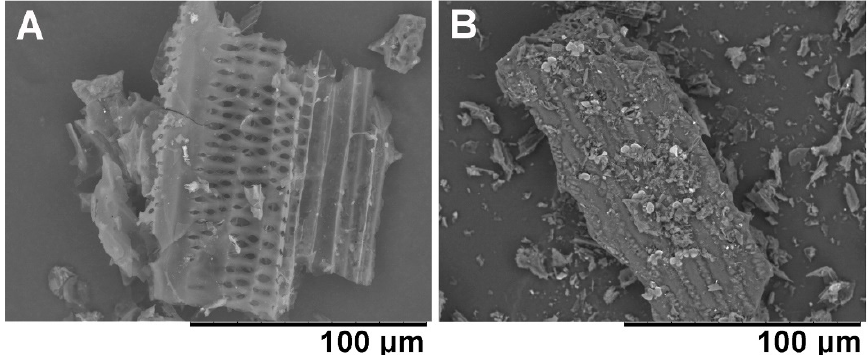
Figure 2. Scanning electron microscope (SEM) images of corncob biochar. ( A ) SEM image of untreated biochar (control); ( B ) SEM image of biochar adsorbed with Bacillus mucilaginosus cells.